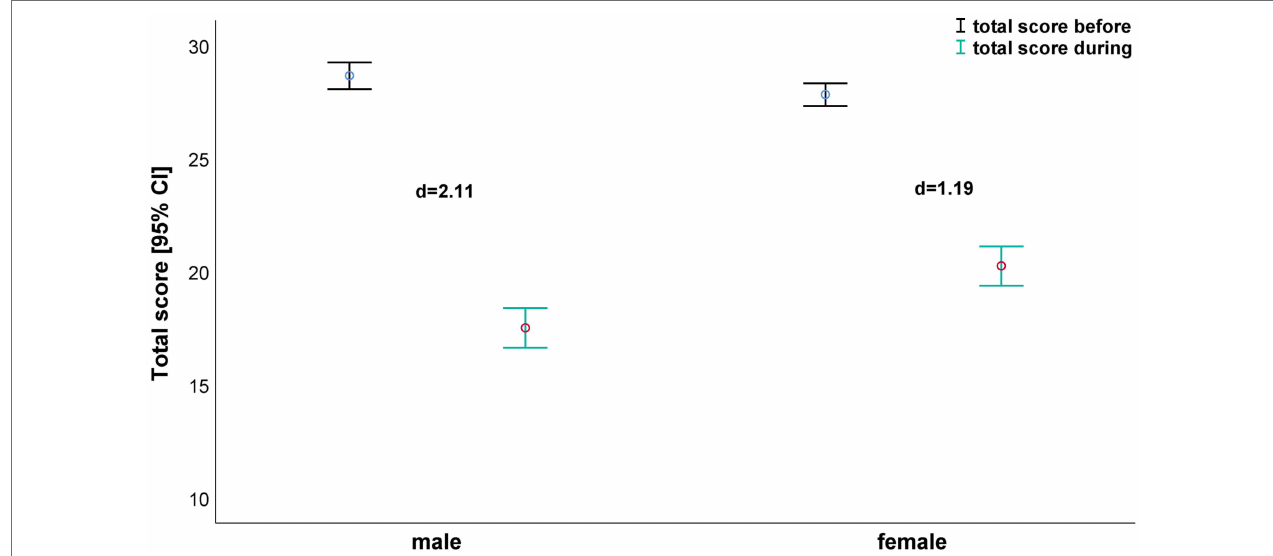
FIGURE 3 | The total score – depending on gender before and during